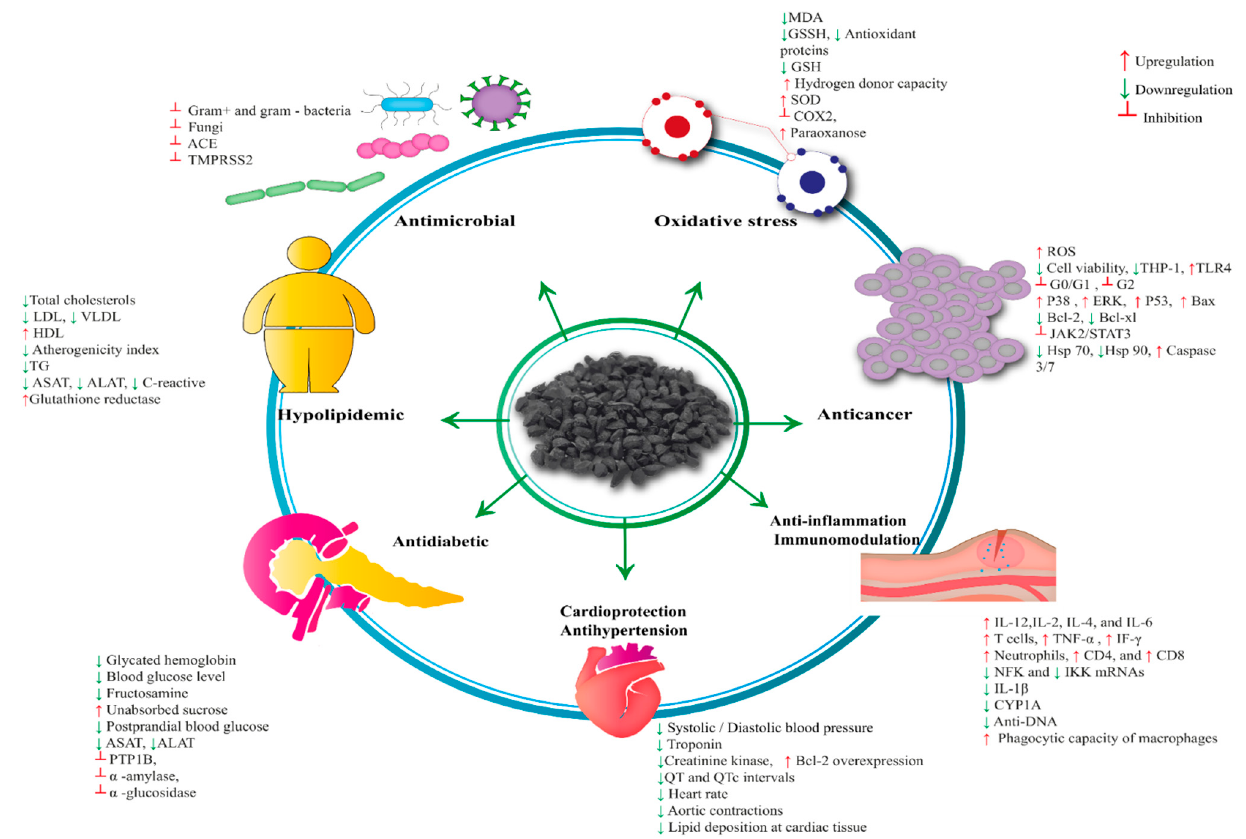
Figure 6. Comprehensive summary of the NS pharmacological activities.